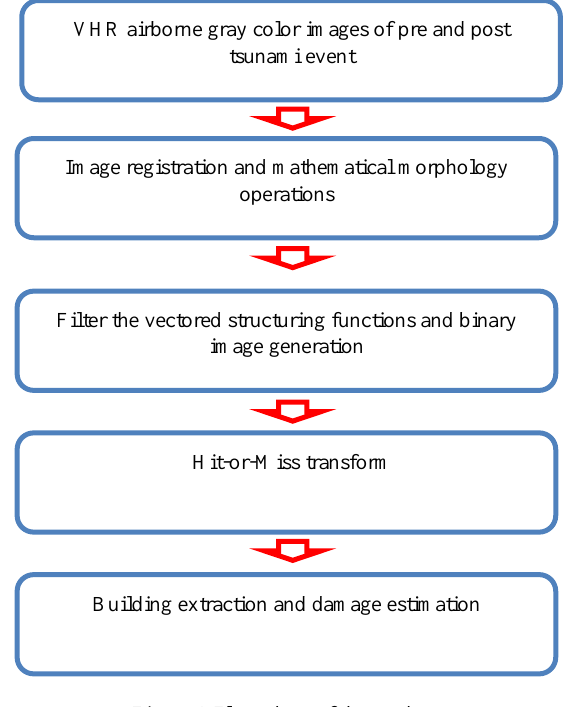
Figure.1 Flow chart of the study